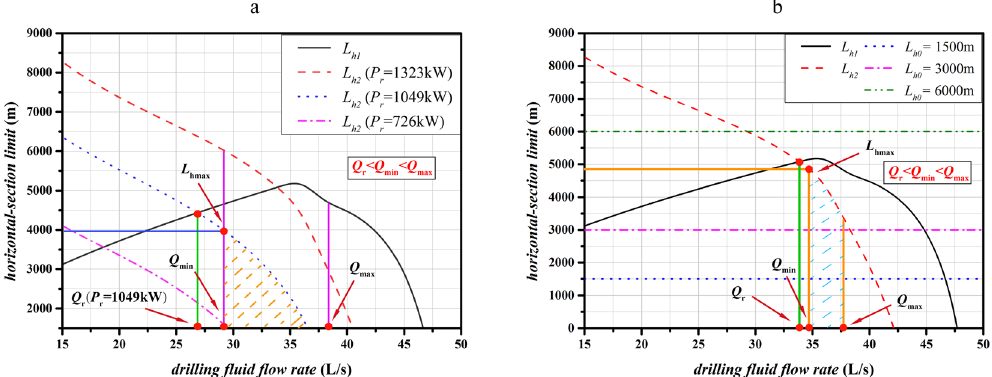
Figure 4. Schematic overview of the situation Q r < Q min < Q max (Case III). ( a ) Effects of different rated pump powers on L h1 and L h2 ; ( b ) Effects of different designed horizontal-section lengths on L h1 and L h2